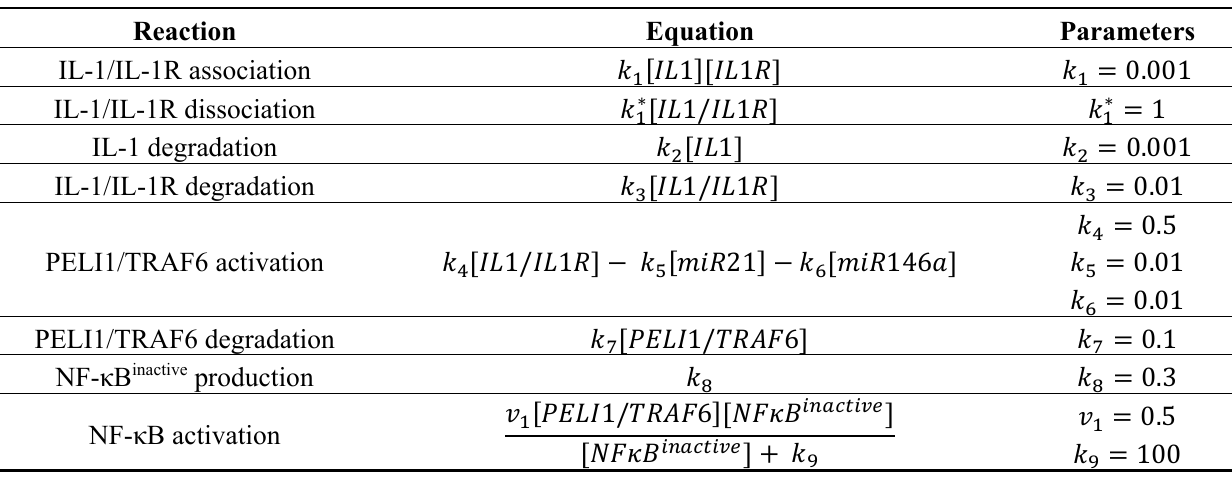
Table A1. Table of all reactions modeled in the Petri net system using either mass action or Michaelis-Menten kinetics, along with their respective